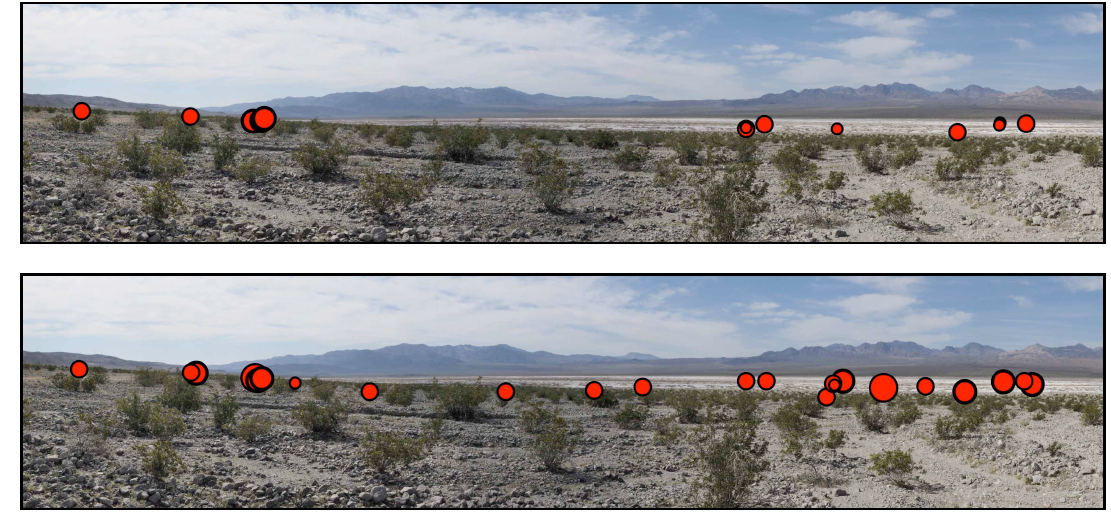
Figure 14. Effect of head motion compensation during horizontal scan. In this example, the same 5 seconds of an observer scanning the horizon is plotted without (top) and with (bottom) head motion compensation. Fixations are plotted as red dots and longer fixations are plotted with a larger dot size. Without head motion compensation, 13 fixations totaling 2069 ms of looking time were captured. With head motion compensation, 23 fixations totaling 4638 ms of looking time were captured.